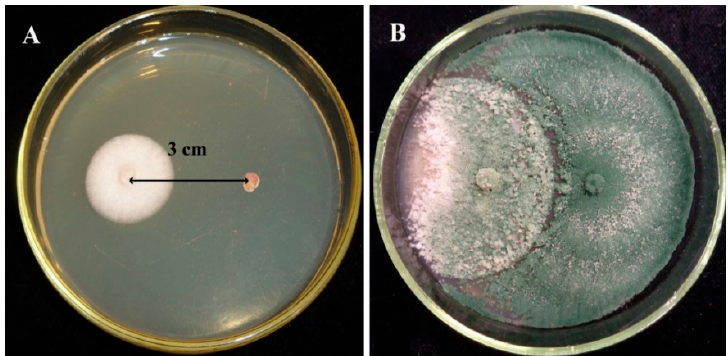
Figure 1. Direct confrontation test between Trichoderma asperellum IRAN 3062C and Alternaria solani SZMC 6241J after ( A ) 2 days and ( B ) 7 days on malt extract agar (MEA) medium.